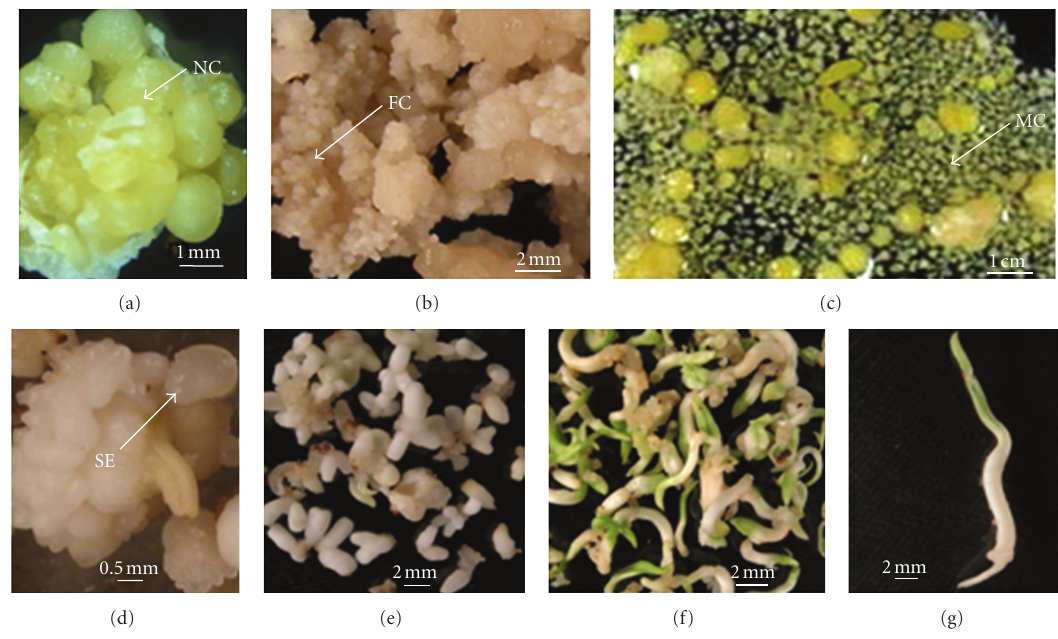
Figure 1: Callogenesis and development of date palm somatic embryos. (a) compact nodular primary callus obtained from foliar explants after 2 months on 2,4-D (2 mg l − 1 ) containing medium; (b) friable secondary callus obtained 1 month after chopping of the primary callus; (c) suspension culture; (d) somatic embryos of stage I, (e) stage, II and III (f), respectively, after 2, 4, and 6 weeks of culture on PGR-free medium; (g) germinated somatic embryo. NC: Nodular callus, FC: Friable callus, MC: microcallus, SE: somatic